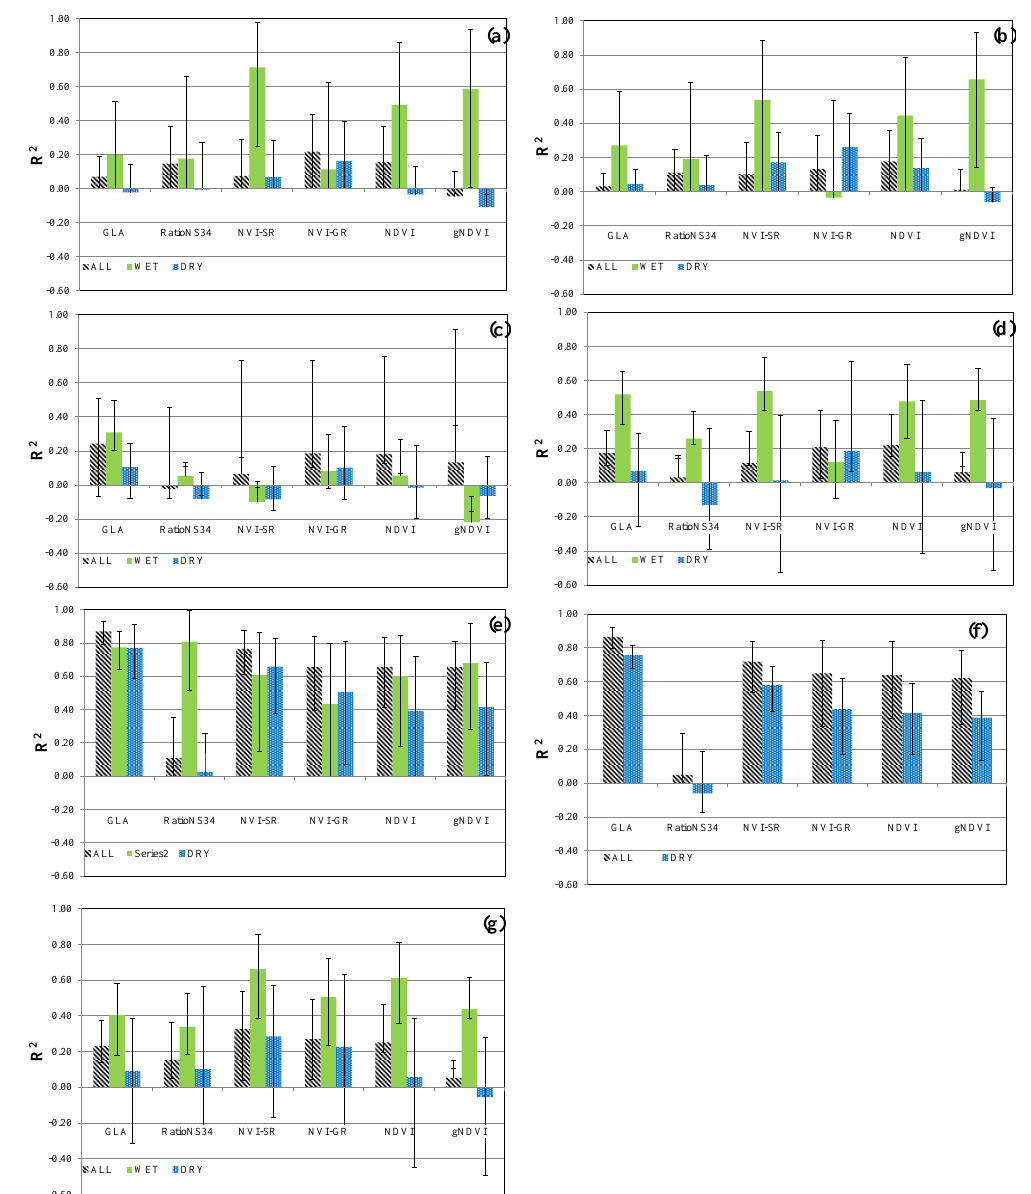
Figure 8. Bias-adjusted bootstrap point estimates of R 2 and corresponding 95% pivotal bootstrap confidence intervals for GAM combina- tions of sensor-derived indices. (a) TotalBiomass, (b) %BareGround, (c) %Litter2D, (d) %TotalVegetation2D, (e) %Green3D, (f) %Green2D, and (g) VegetationHeight. See Table 4 for the